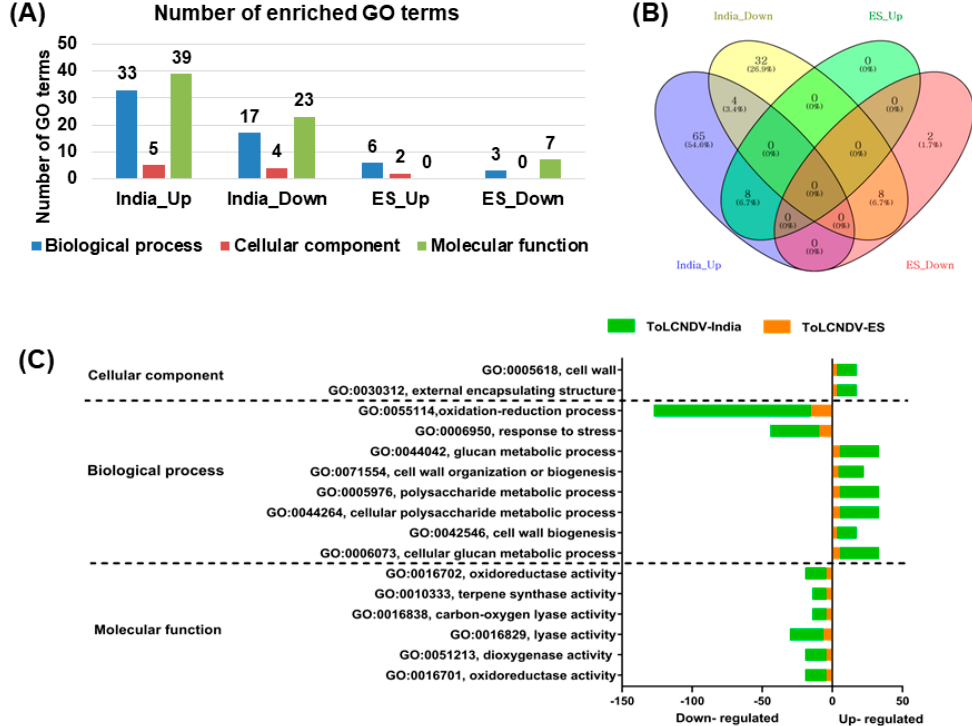
Figure 6. GO enrichment analysis under two ToLCNDV isolates infection. ( A ) The number of identified enriched GO terms. The graph shows the significant upregulated and downregulated GO terms involved in biological process (blue bars), cellular component (dark-red bars), and molecular function (green bars). ( B ) The Venn diagram represents the DEGs among 4 groups (India-Up, India- Down, ES-Up, and ES-Down). ( C ) The GO classification in both ToLCNDV conditions. The number of upregulated and downregulated genes calculated in ToLCNDV-India and -ES, represented by the green and orange colors according to the